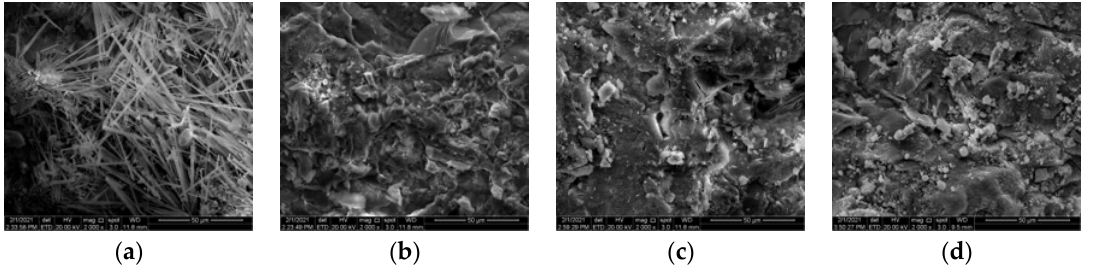
Figure 9. Section SEM images of SFSCC under 30 dry–wet cycles of sulfate attack. ( a ) SFSCC-0 (2000×); ( b ) SFSCC-40 (2000×); ( c ) SFSCC-50 (2000×); ( d ) SFSCC-60 (2000×). (2000 × ); ( b ) SFSCC-40 (2000 × ); ( c ) SFSCC-50 (2000 × ); ( d ) SFSCC-60 (2000 ×